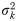
Phylodynamic analysis of a HIV-1 sub-epidemic among MSM in Switzerland.(a) Maximum clade credible phylogeny reconstructed from 200 HIV pol sequences. Lineages are colored by their expected degree in the network based on their ancestral degree distribution inferred under the pairwise coalescent model. The ancestral degree distribution of each lineage back through time was computed while conditioning on the median posterior estimate of all parameters. Inset shows the inferred degree distribution for the entire network (capped at k = 10 for visual simplicity). (b-c) Posterior (dark grey) and prior (light grey) distributions of the mean degree μk and variance σk2 of the degree distribution. (d) Estimates of the basic reproductive number R0 inferred under the pairwise coalescent (grey) and under the random mixing coalescent model (red).